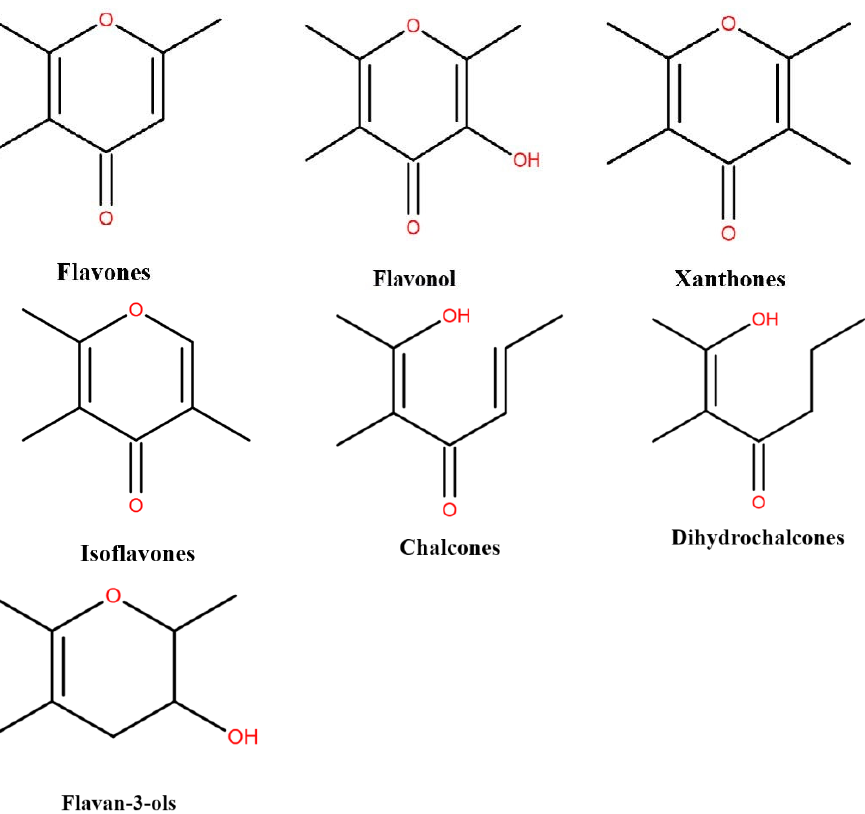
Figure 2. Structure of different